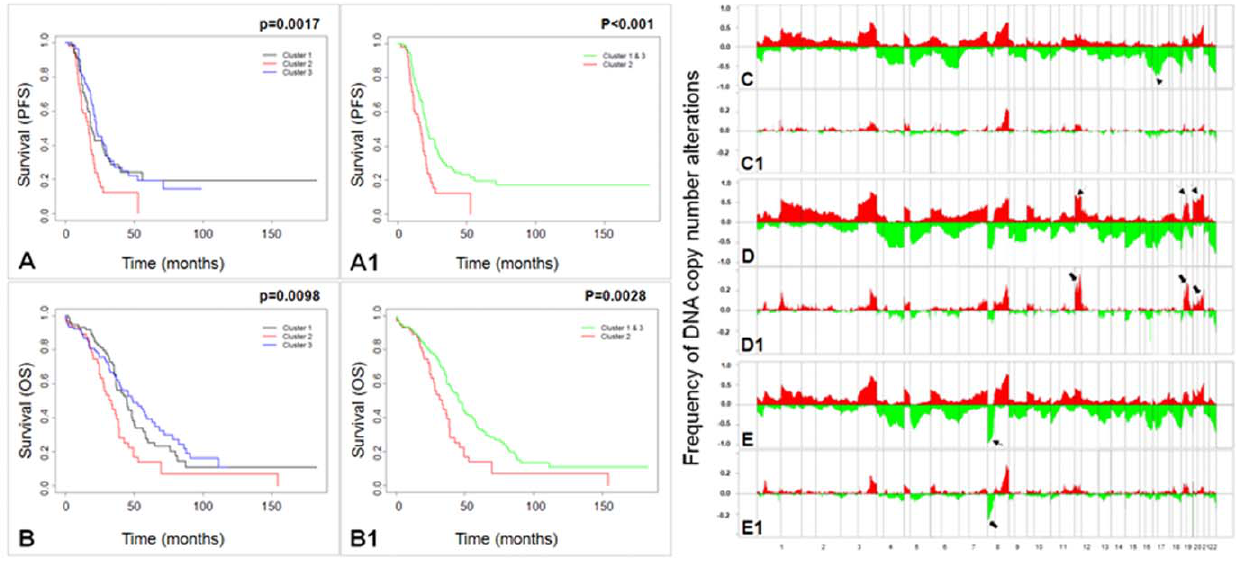
Figure 5. Validation of classification accuracy in TCGA dataset. Kaplan-Meier plots for TCGA subgroups identified through supervised clustering. Subgroups are clinically distinct with regard to both ( A ) progression-free survival (p=0.0017) and ( B ) overall survival (p=0.0098). The combined cluster of subgroup 1 and 3 is clinically distinct from subgroup 2 with regard to both ( A1 ) progression-free survival (p , 0.001) and ( B1 ) overall survival (p=0.0028). C–E ) Frequencies of genome copy number gain and loss plotted as a function of genome location from 1pter to 22qter in the three clusters identified in the TCGA dataset. Vertical lines indicate chromosome boundaries, and vertical dashed lines indicate position of centromeres along the chromosomes. Positive and negative values indicate frequencies of tumors showing copy number increases (gain shown in red) and decreases (loss shown in green). C1–E1 ) Frequencies of tumors showing high-level amplifications and homozygous deletions in the three TCGA clusters. Data are displayed as described in C–E. Arrows indicate genomic regions where the three clusters differ